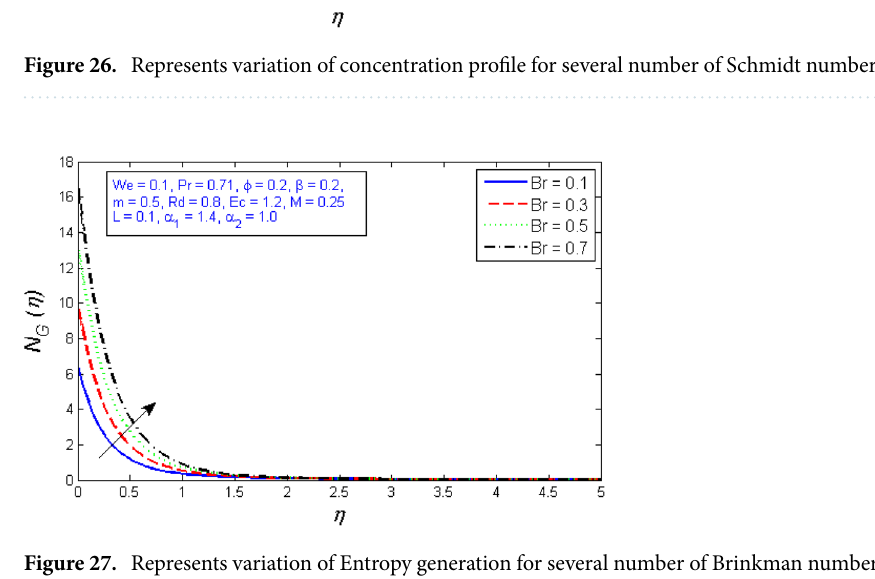
Figure 27. Represents variation of Entropy generation for several number of Brinkman number Br